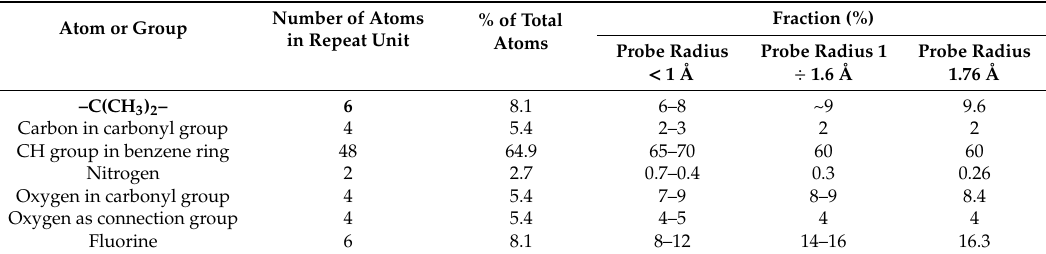
Table 6. Fraction of surface of FVEs (in %) occupied by various chemical species in PEI-304 as a function of the size of a probe. Here also, as in Table 5, hydrogen atoms were not accounted